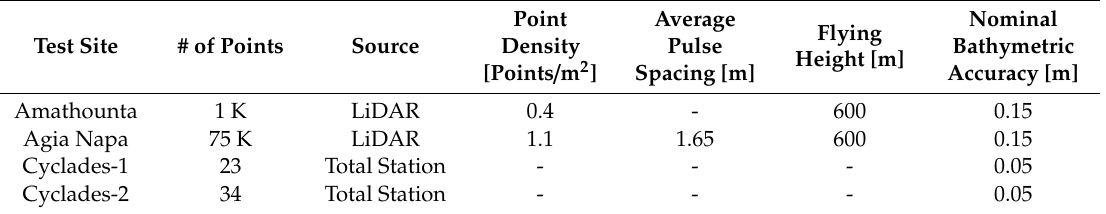
Table 2. Ground truth data